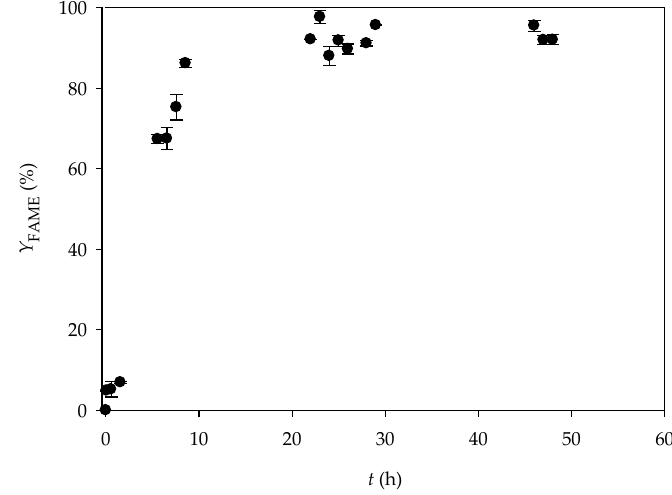
Figure 2. Lipase catalysed biodiesel synthesis in a batch reactor.